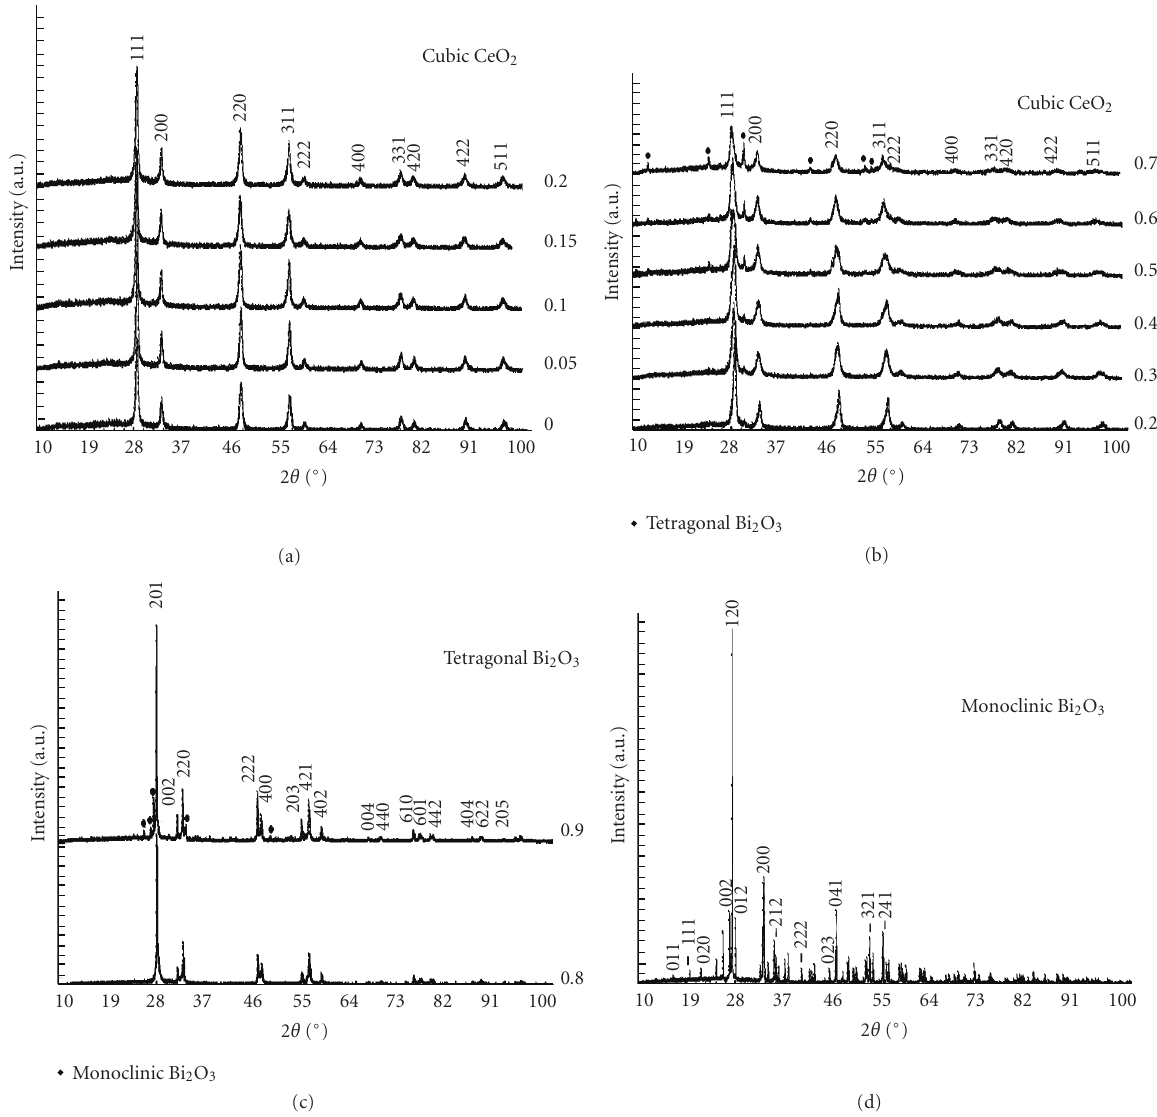
Figure 1: XRD patterns ( λ CuK α 1 = 1 . 54 · 10 − 10 m) of pure samples (1 − x ) CeO 2 , x/ 2 Bi 2 O 3 heated at 600 ◦ C. (a) XRD patterns for 0 < x < 0 .